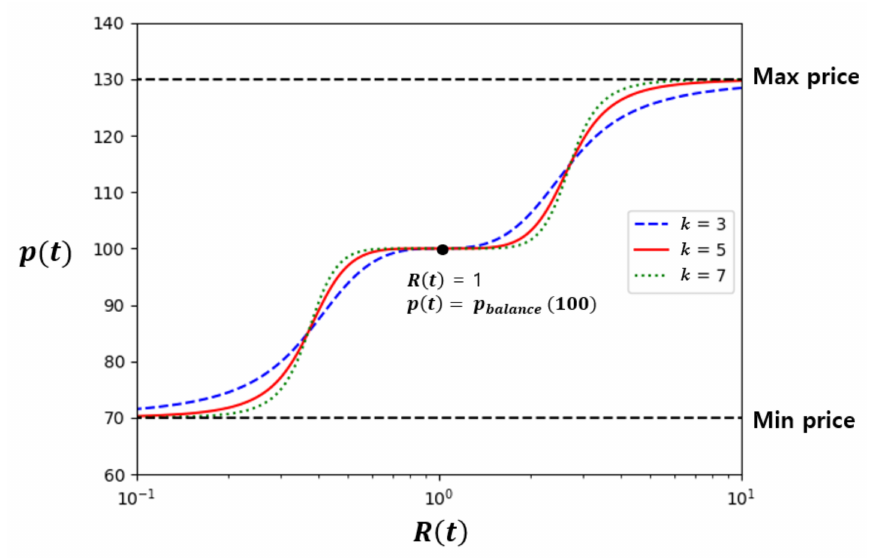
Figure 2. The proposed dynamic pricing with varying k ( p balance = 100, p con = 30 )